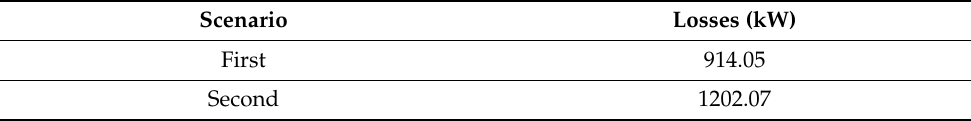
Table 7. Comparison of objective functions between